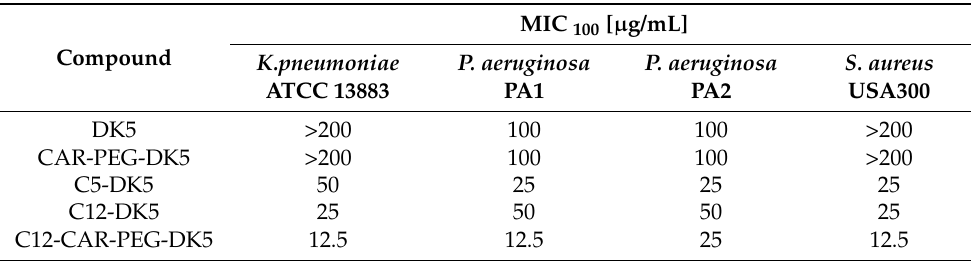
Table 3. Antibacterial properties of the selected compounds against clinical isolates of P. aeruginosa , K. pneumonia and MRSA